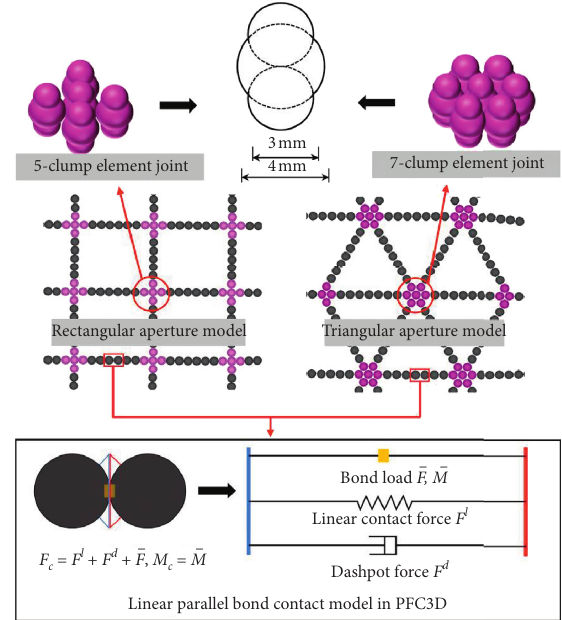
Figure 2: Specific structures of the joints and the behavior component of the parallel bond contact